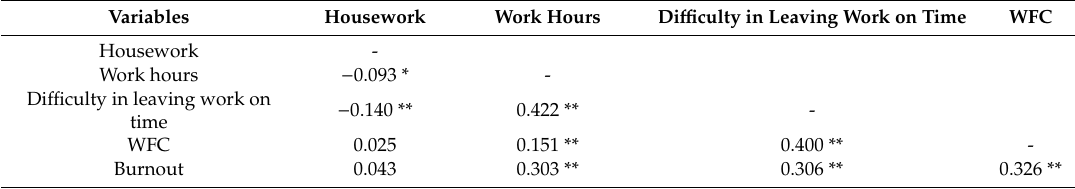
Table 2. The correlations of research variables ( n = 738).